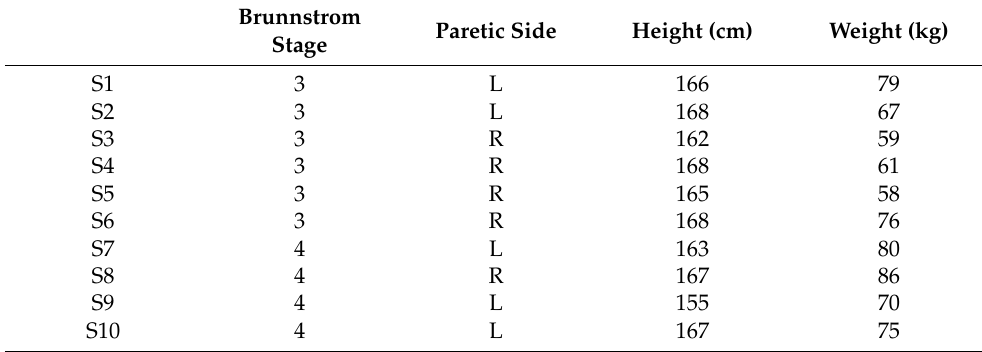
Table 7. Information of stroke